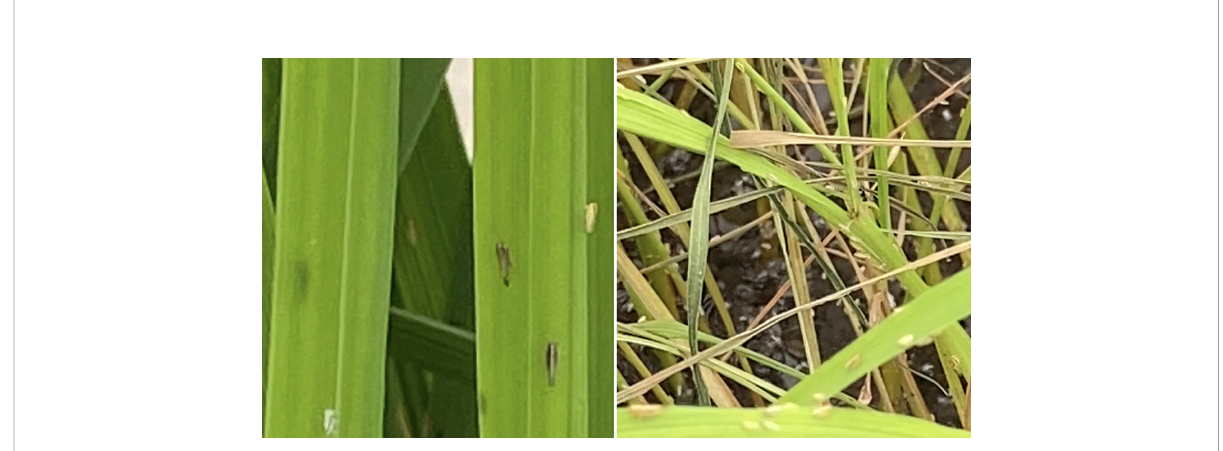
FIGURE 10 (left) Infected rice panicle showing planthopper insect and larvae, which transmits RHBV, and (right) physically damaged rice